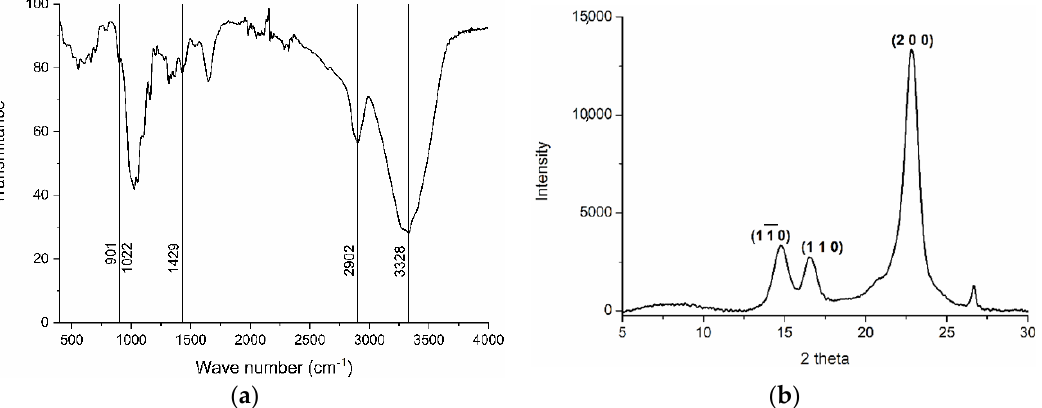
Figure 4. Infrared spectrum ( a ) and XRD diffractograms ( b ) of cellulose extracted from the tunic of Styela clava .